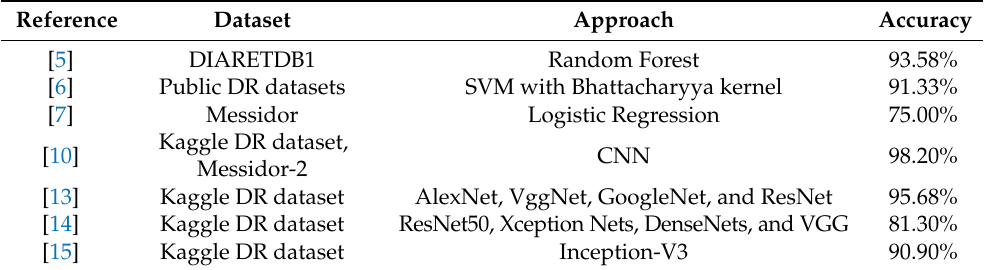
Table 1. Summary of some DR automatic detection approaches applied by other related